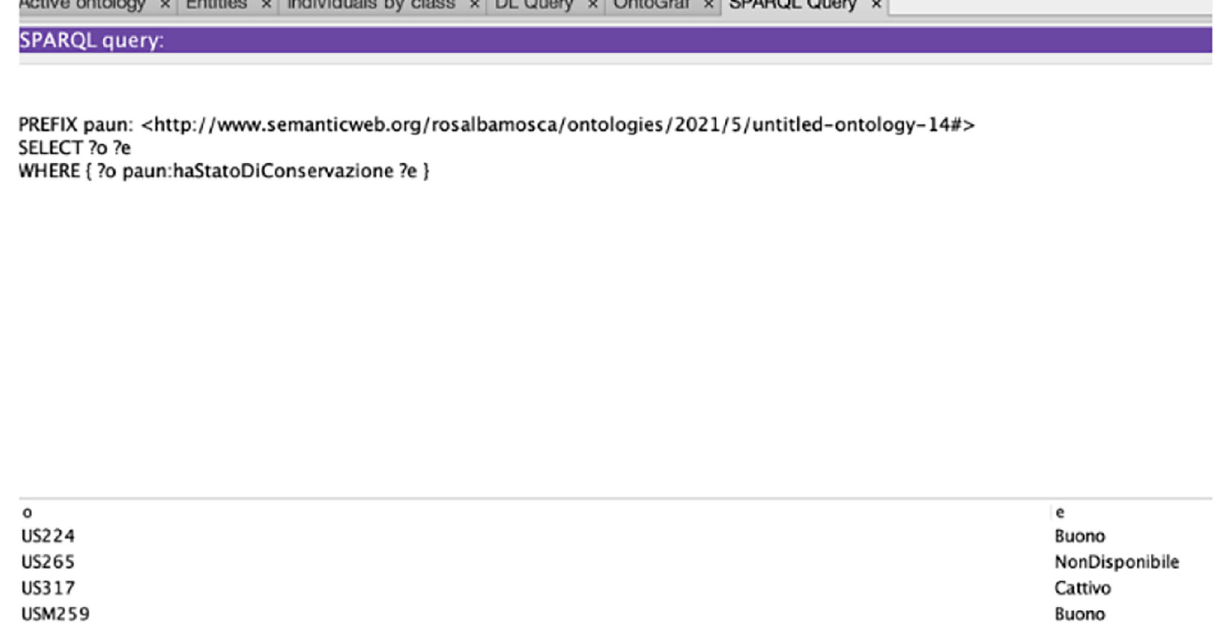
FIGURE 7 | Semantic query of the PAUN Ontology on instances from the stratigraphic unit